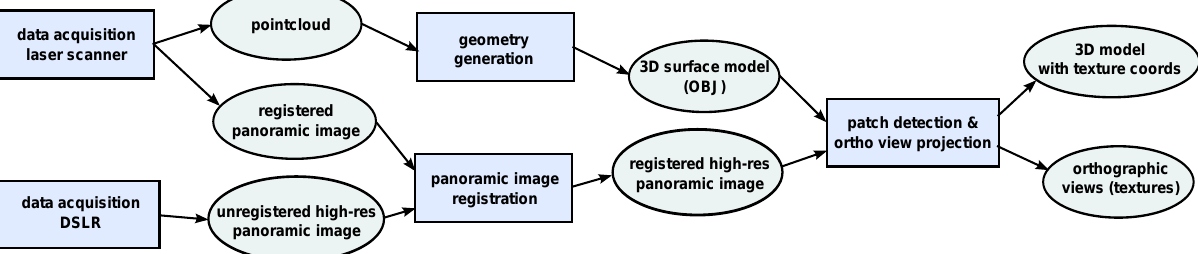
Figure 2: Overview of the whole work flow: boxes depict methods and ellipses reflect (intermediate) results. First, the acquired input data is registered and preprocessed (geometry generation and panoramic image registration). Afterwards, the patch detection and ortho view projection step identifies rectangular patches in the input geometry and generates an orthographic image for each patch, as well as texture coordinates for the 3D surface model.